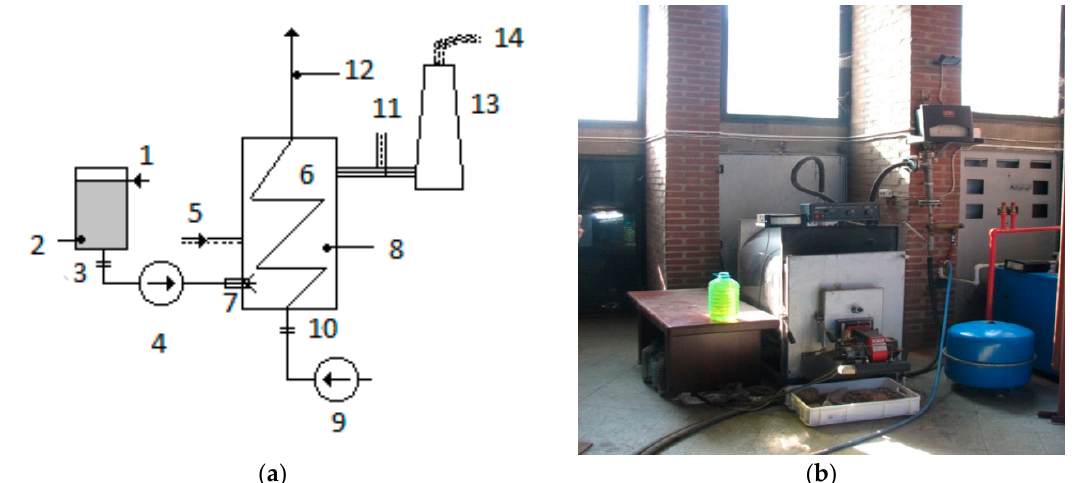
Figure 2. Pilot boiler: ( a ) schematic diagram; ( b ) actual installation.